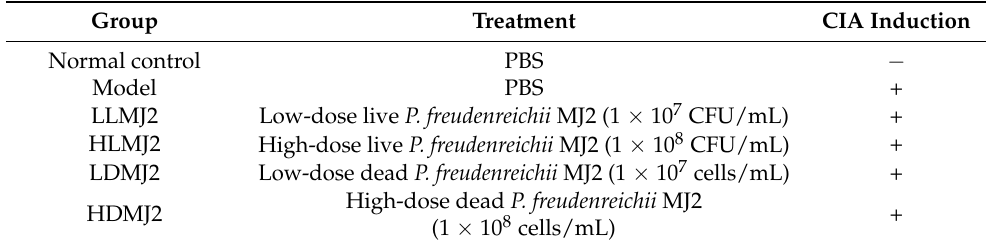
Table 2. Animal groups were used in this study. Group Treatment